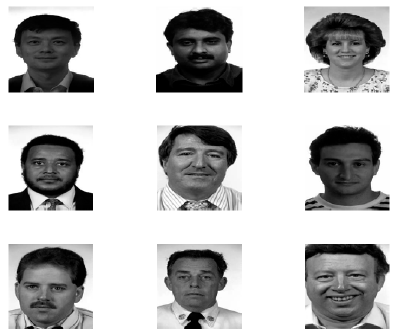
Figure 13. Sample of greyscale facial images from Face Recognition Technology (FERET) database [26] used as original biometrics.